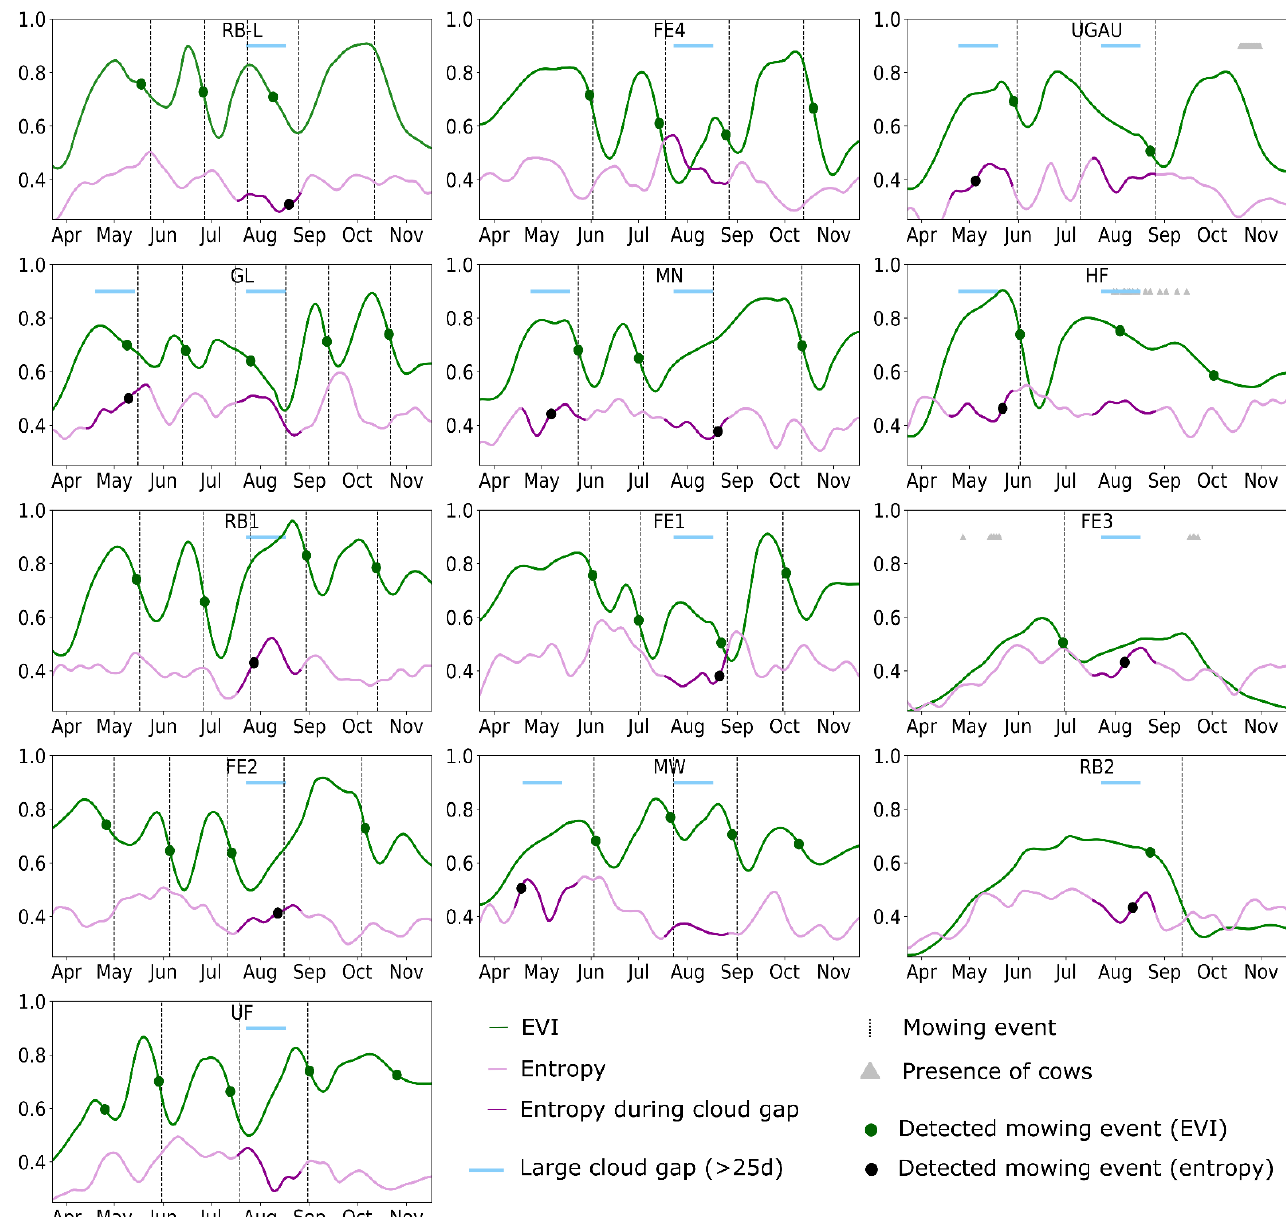
Figure 5. Temporal profiles of gap-filled and smoothed EVI and PolSAR entropy for center pixels of the parametrization grassland parcels with varying mowing regimes, including the actual and detected mowing events as well as gaps within the optical